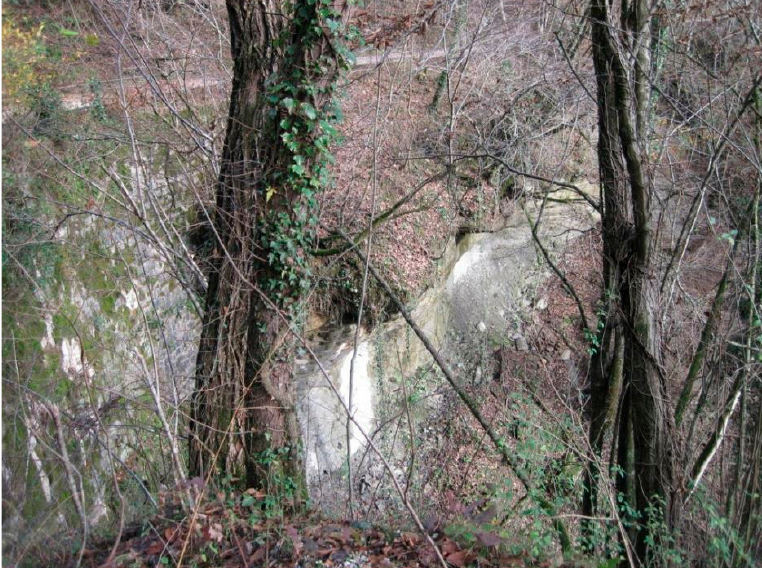
Figure 8. Landslide photograph code 025021_05c, translational sliding.